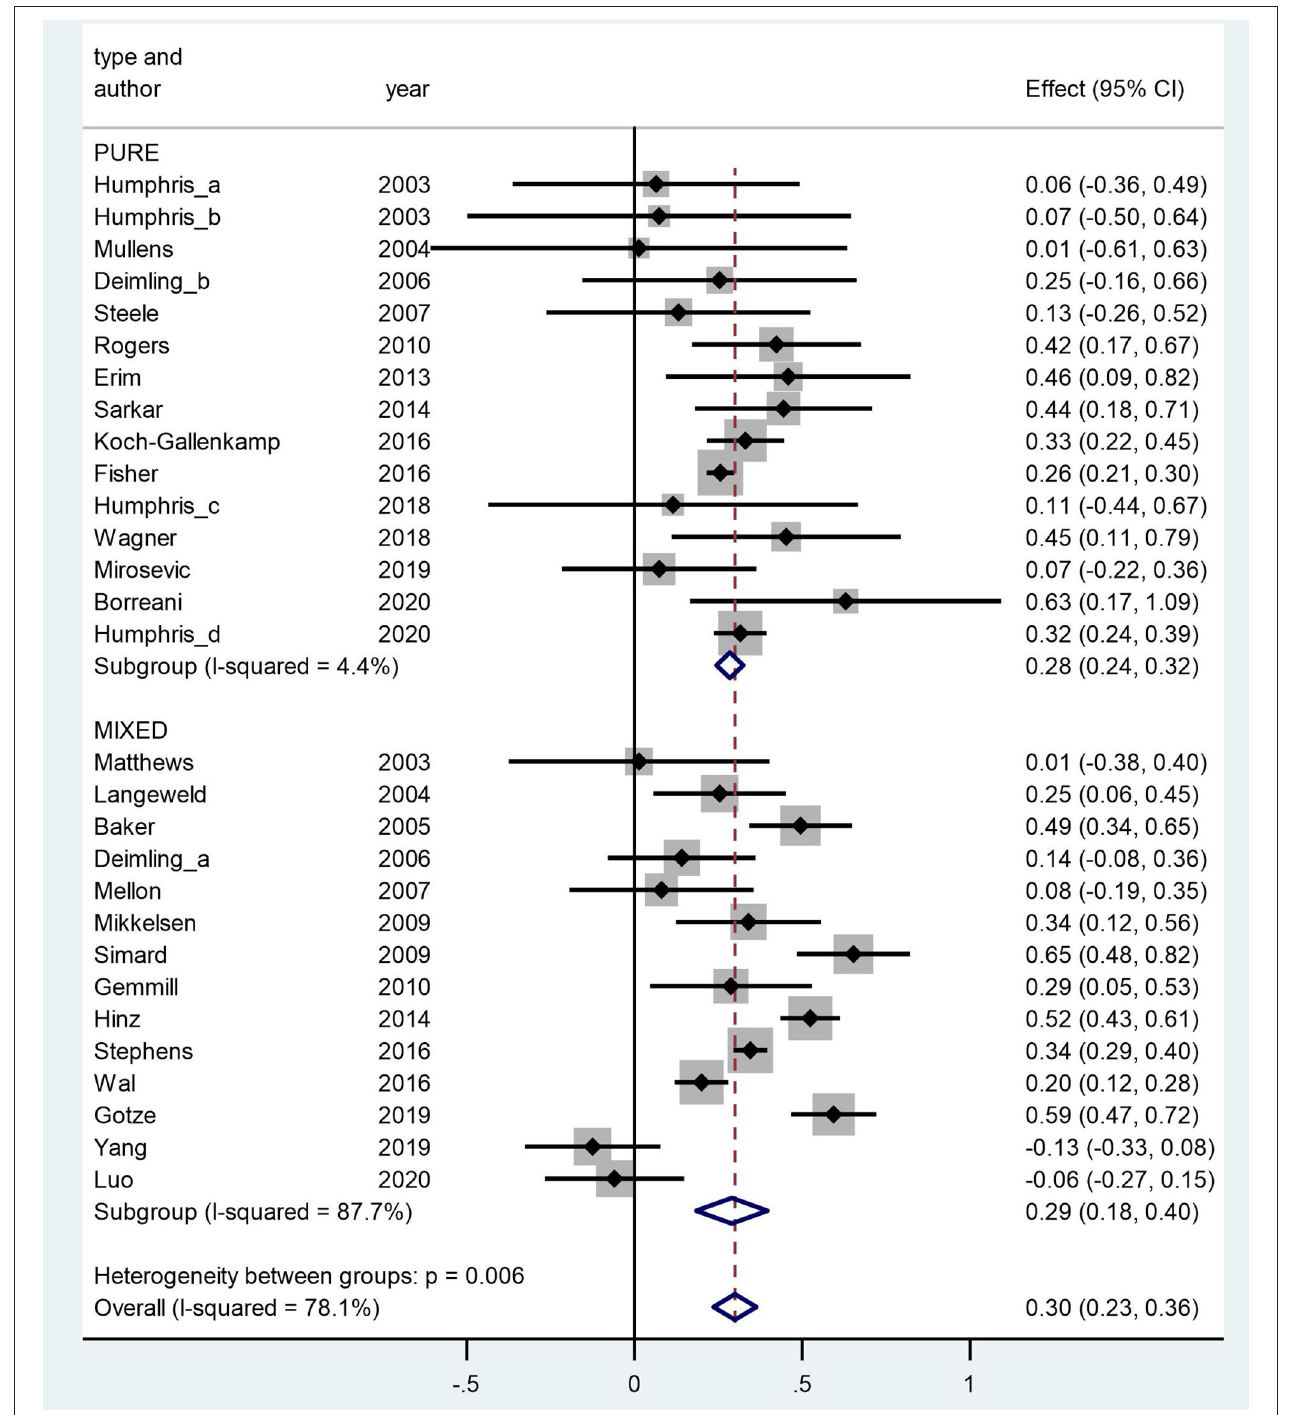
FIGURE 2 | Forest plot of fears of cancer recurrence (FCR) and gender in a random-effects model. Weights are from random-effects model.